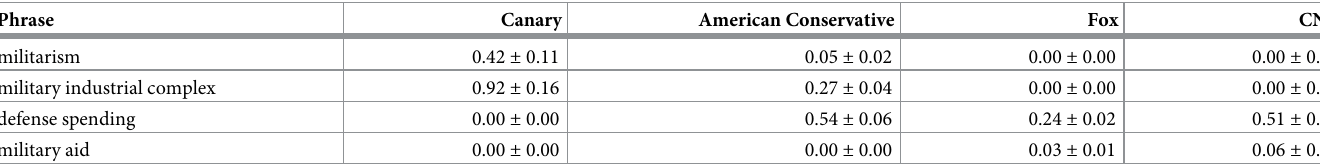
Table 4. Military spending phrase usage per